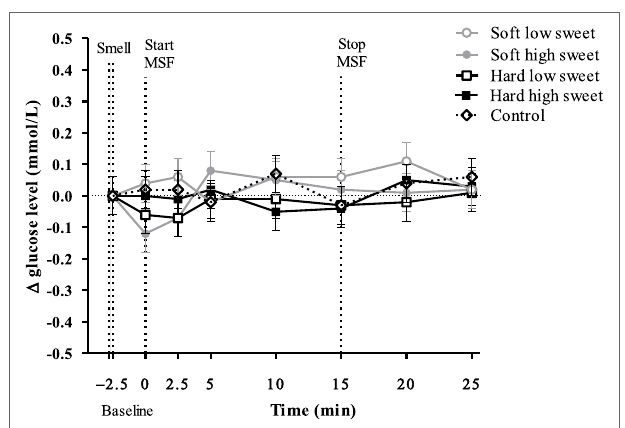
FigUre 4 | Estimated mean ± SEM Δ glucose concentration (mmol/l) from baseline over time for all treatments and the control condition. No significant differences were found between treatments or control condition at any time point ( p =